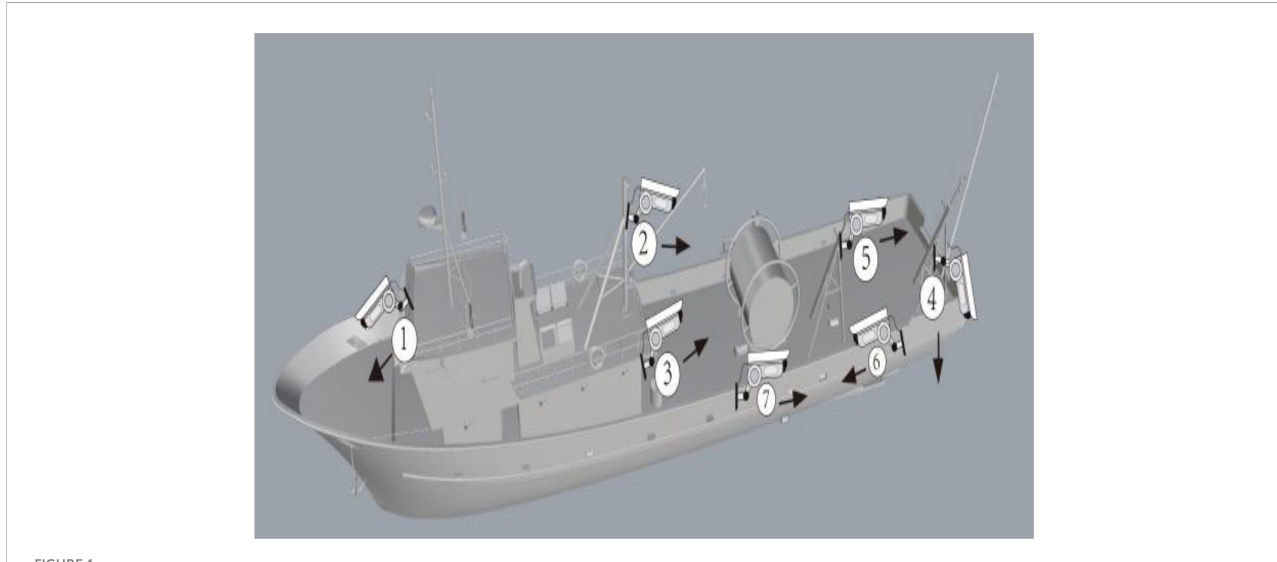
FIGURE 1 The position of the cameras in Xinhai